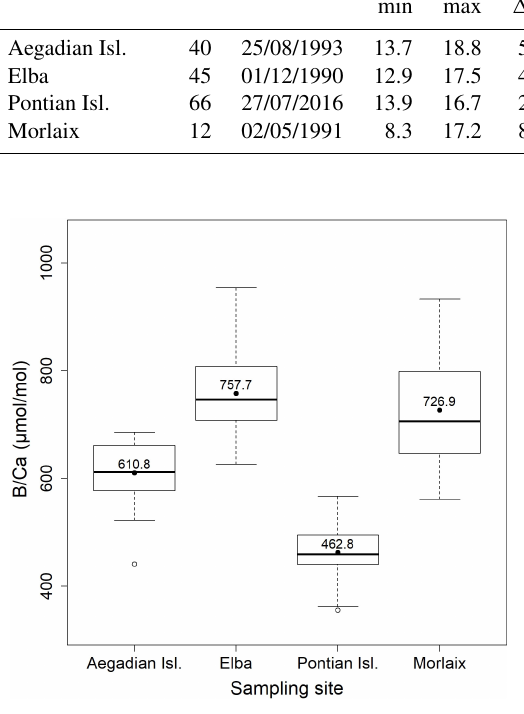
Figure 9. Box plot of the statistical tests performed to evaluate the differences of B / Ca in L. corallioides collected at different sam- pling sites. The horizontal black lines indicate the median values. The black dots and the numbers inside the plot indicate the mean